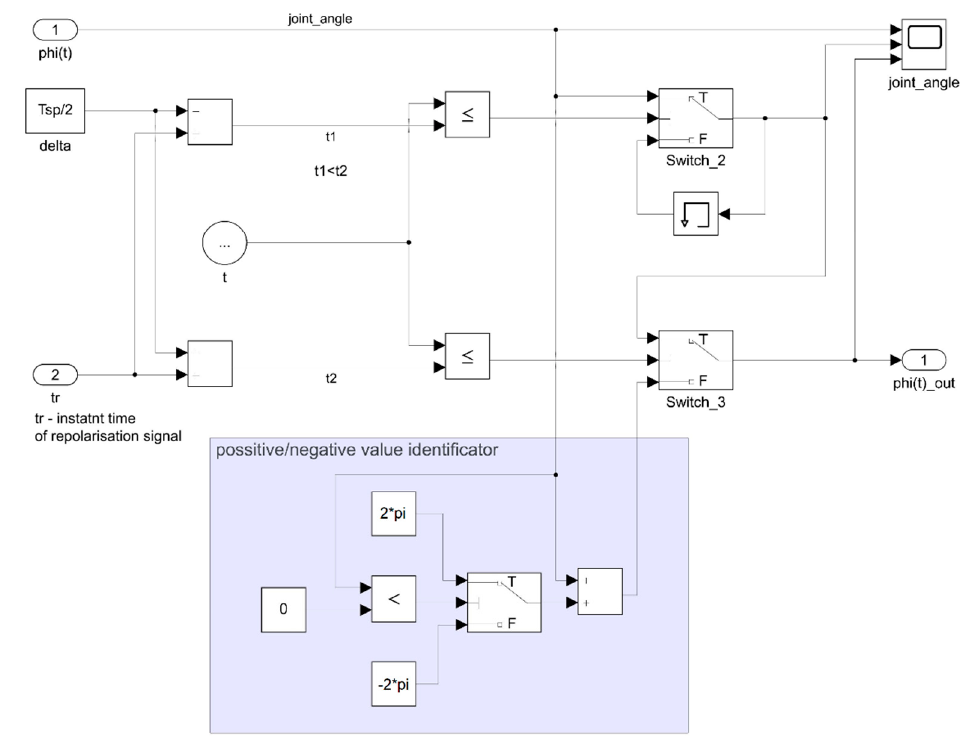
Figure 6. Constructed repolarizer. When the data were uploaded, it was first necessary to establish the moment of repolarization t r with the precision of δ = +/ − 0.0025 s when the variable ϕ ( t ) = 0, i.e., cuts through the time axis. Under the assumption of reaching the upper or the lower working interval limit < − π , + π > of the joint coordinate. The variable at the output from the repolarize is ϕ out ( t ). It was necessary to meet the following